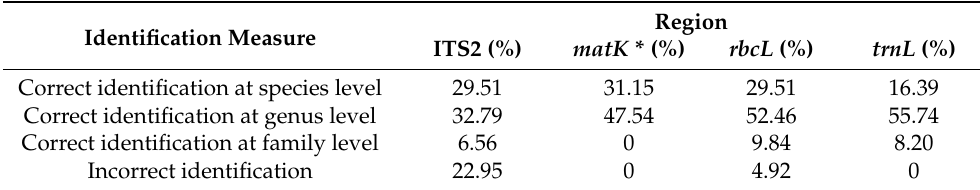
Table 3. Identification success rates of each region through the BLAST method after validating with the species name from morphologicy identification.